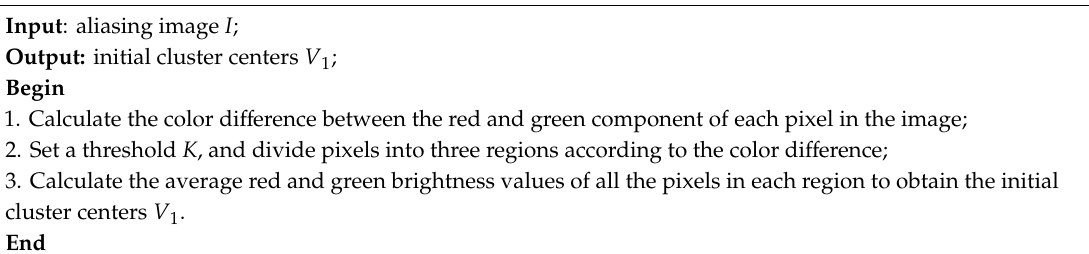
Algorithm 1 The process for initializing cluster centers